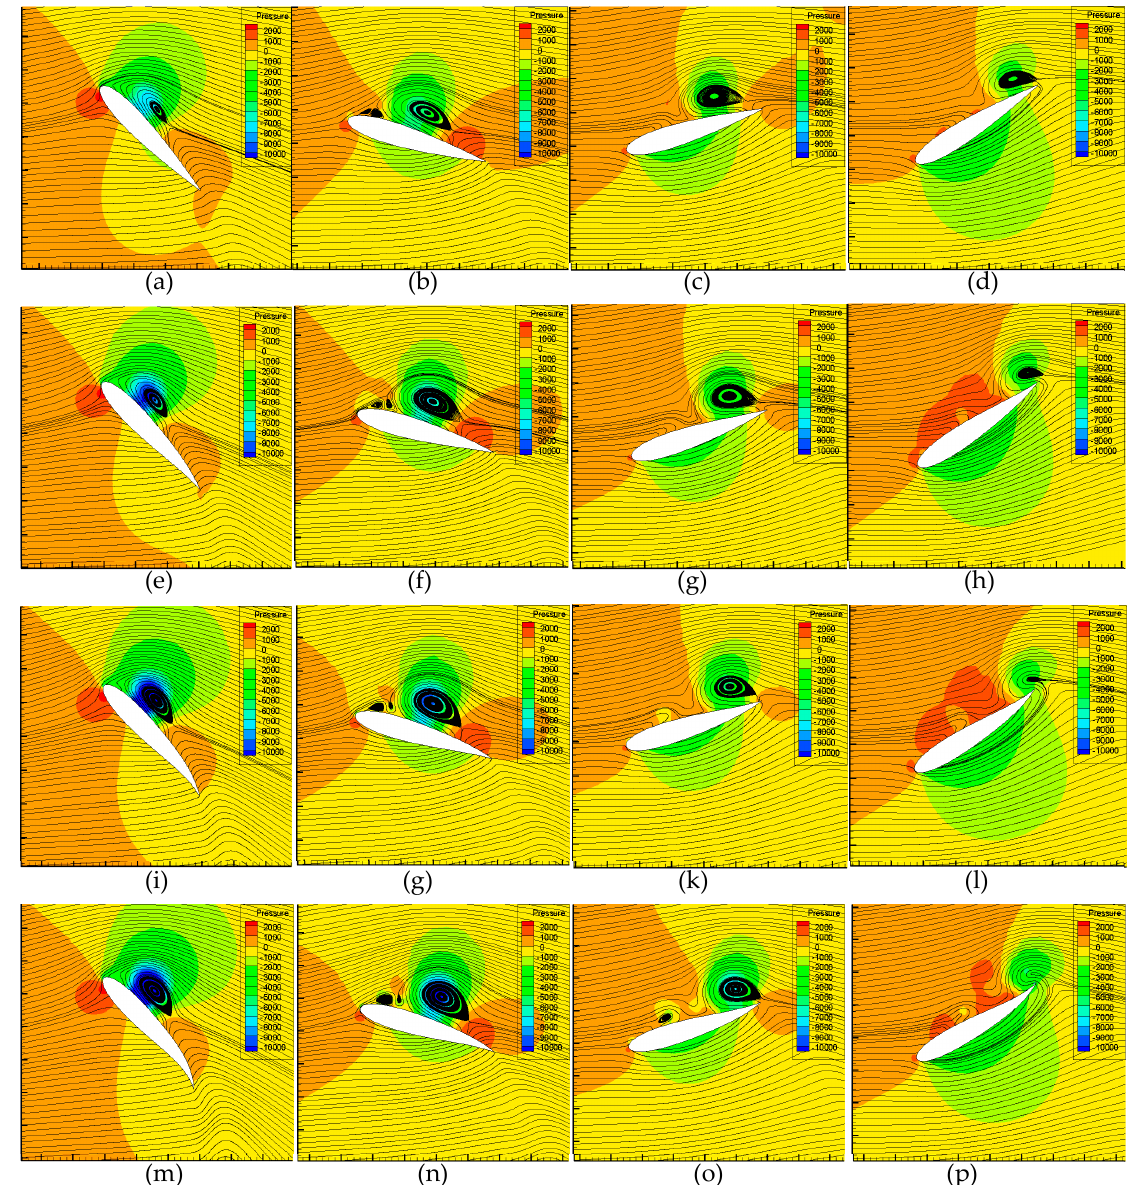
Figure 10. Contours of vortices with streamlines and pressure (Pa) of flexible hydrofoil in the case n = 5 and f *= 0.13 (the thicker the blue, the stronger the vortex). ( a ) rigid, θ = –45 ° , ( b ) rigid, θ = –16 ° , ( c ) rigid, θ = 16 ° , ( d ) rigid, θ = 31 ° , ( e ) δ c = 0.05 c , θ = –45 ° , ( f ) δ c = 0.05 c , θ = –16 ° , ( g ) δ c = 0.05 c , θ = 16 ° , ( h ) δ c = 0.05 c , θ = 31 ° , ( i ) δ c = 0.1 c , θ = –45 ° , ( j ) δ c = 0.1 c , θ = –16 ° , ( k ) δ c = 0.1 c , θ = 16 ° , ( l ) δ c = 0.1 c , θ = 31 ° , ( m ) δ c = 0.15 c , θ = –45 ° , ( n ) δ c = 0.15 c , θ = –16 ° , ( o ) δ c = 0.15 c , θ = 16 ° , ( p ) δ c = 0.15 c , θ = 31 ° .